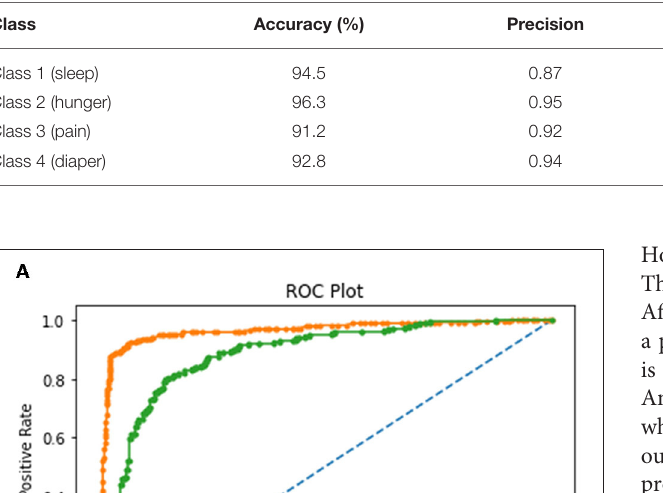
Figure 12A represents the epoch vs. loss graph and Figure 12B illustrates the epoch vs. accuracy graph of the proposed multistage heterogeneous stacking ensemble classification model 2 for a maximum of 175